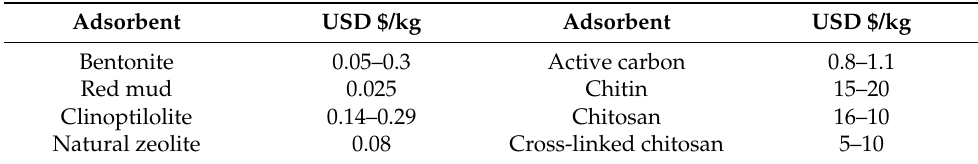
Table 1. The effective cost of effluent treatment with clay and other adsorbents [3].